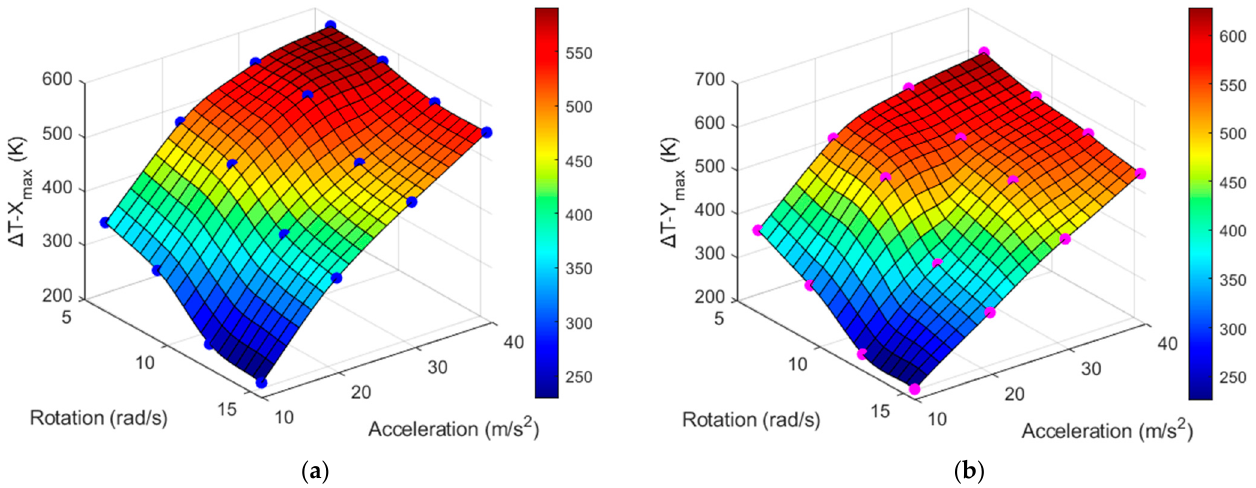
Figure 17. Data obtained after interpolation of Δ T_X max ( a ) and Δ T_Y max ( b ) w.r.t acceleration and rotation.